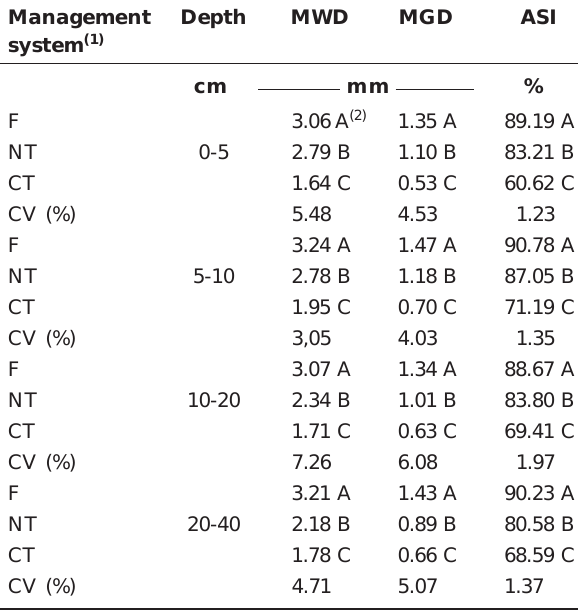
Table 2. Effect of the soil management system on mean weighted diameter (MWD), mean geometric diameter (MGD) and aggregate stability index